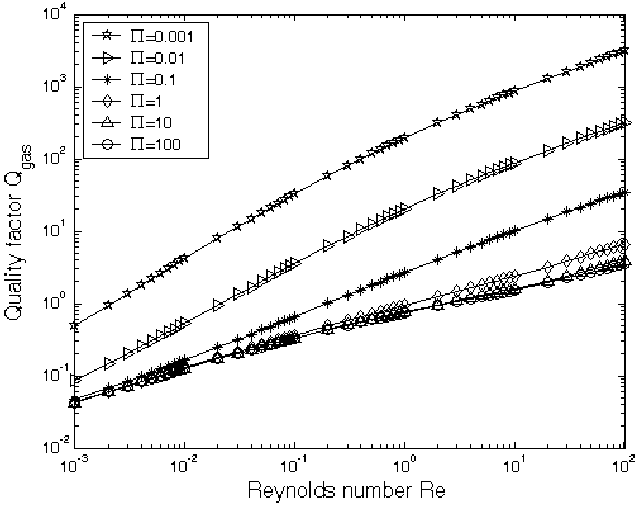
Figure 7. The quality factor Q fundamental mode at different natural scaling parameter П